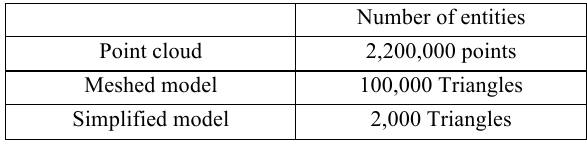
Table 1: summary of amounts of data for the object Guard Room